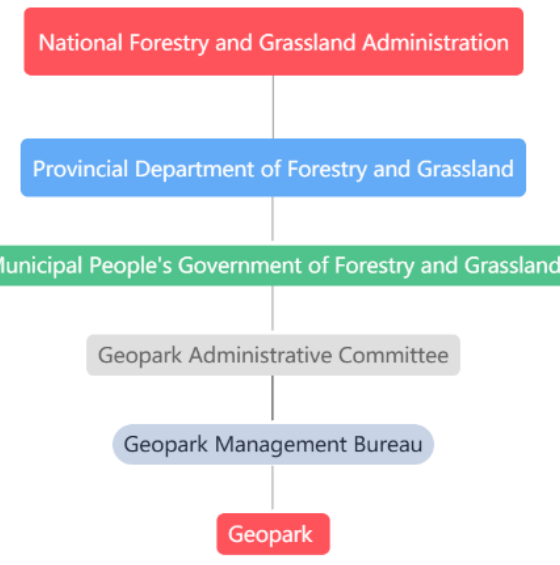
Figure 9. Chinese Geoparks Management Structure.